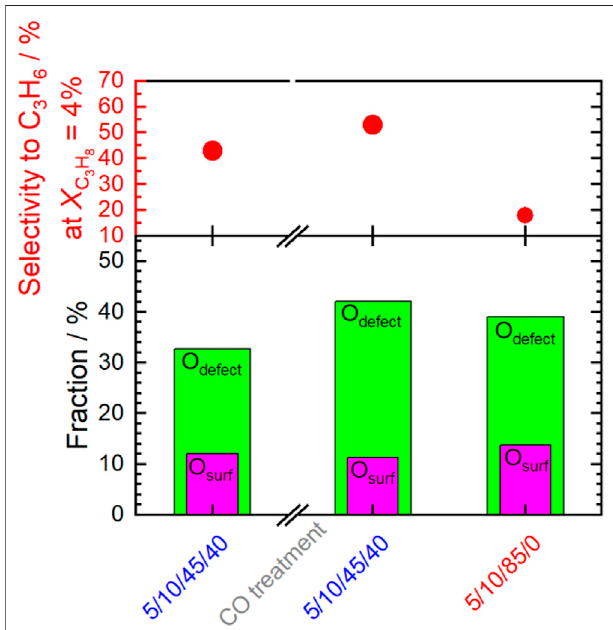
FIGURE 13 | Selectivity to propene at 4% conversion of propane in wet feed(5/10/45/40),inwetfeedafterCOtreatmentandindryfeed(5/10/85/0)in thetop panel.Correspondingfractions ofO defect and O surface areplottedinthe bottom panel.